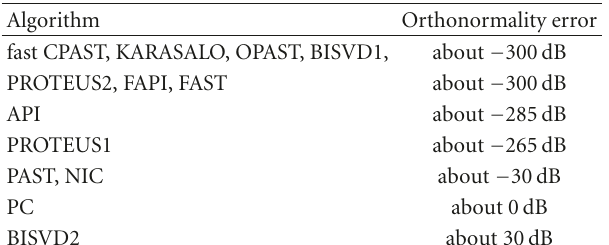
Table 7: Average of orthonormality error given by (63) for algorithms mentioned in Table 6 in the third simulation scenario. Algorithm